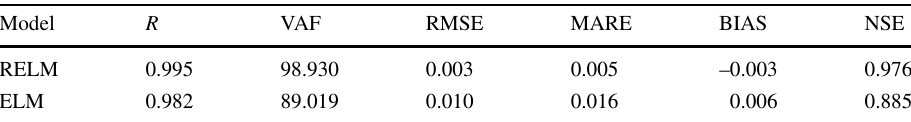
Fig. 13 Comparison of coef- ficients of discharge simulated by RELM and ELM